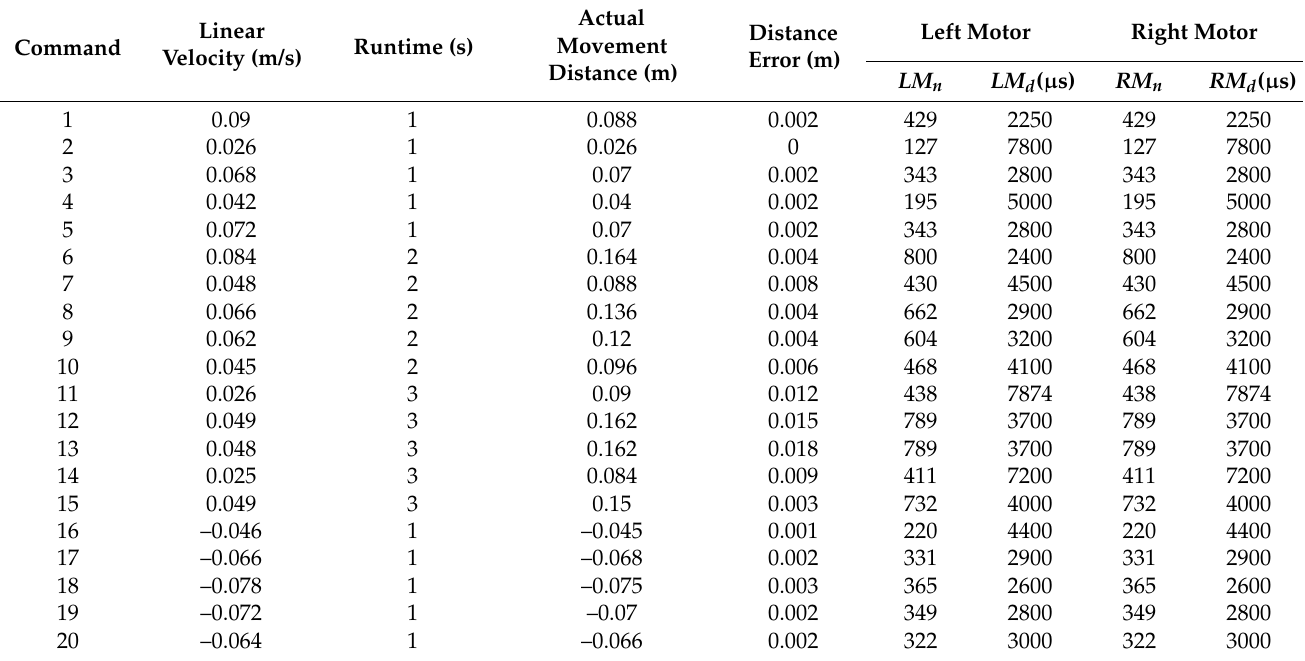
Table 5. Movement distances and distance errors for different speed